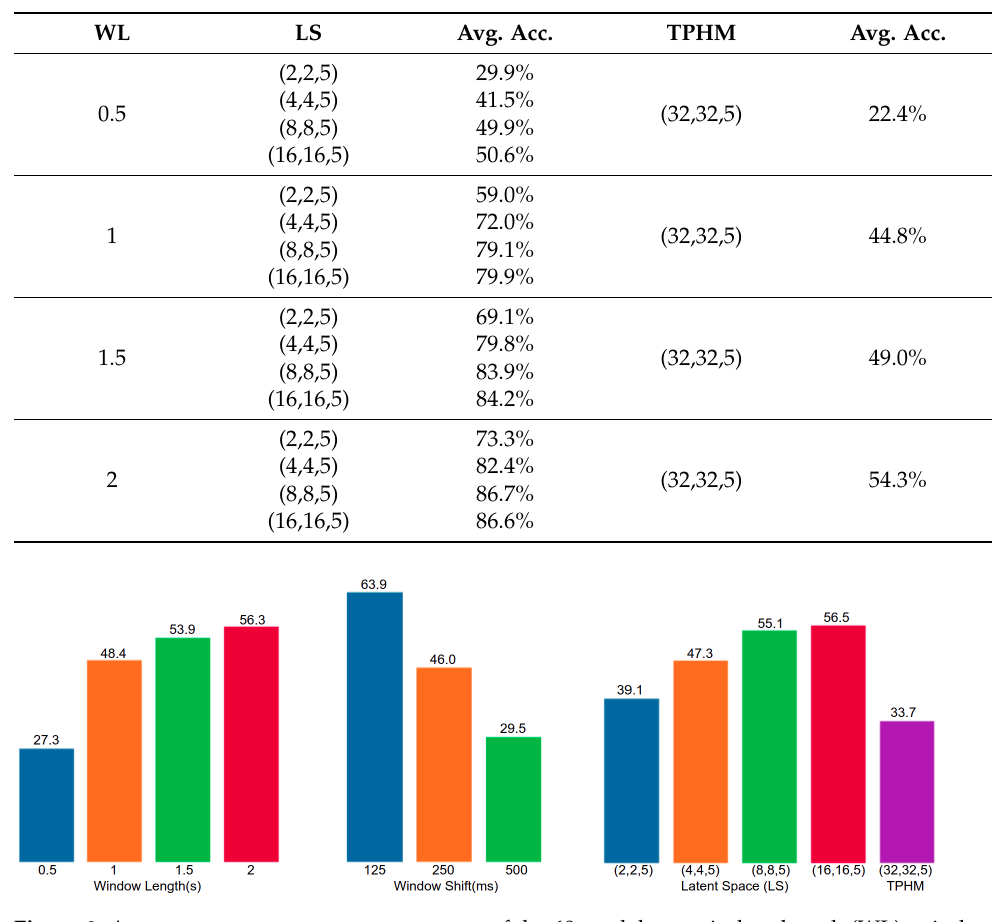
Figure 8. Aggregate mean accuracy percentage of the 60 models on window length (WL), window shift (WS), and latent space (LS).